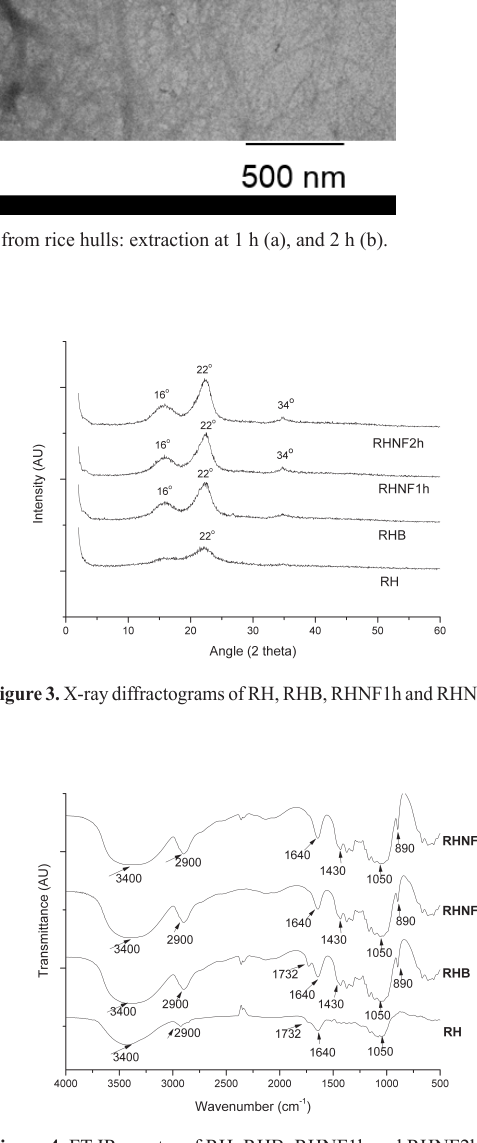
Figure 4. FT-IR spectra of RH, RHB, RHNF1h and